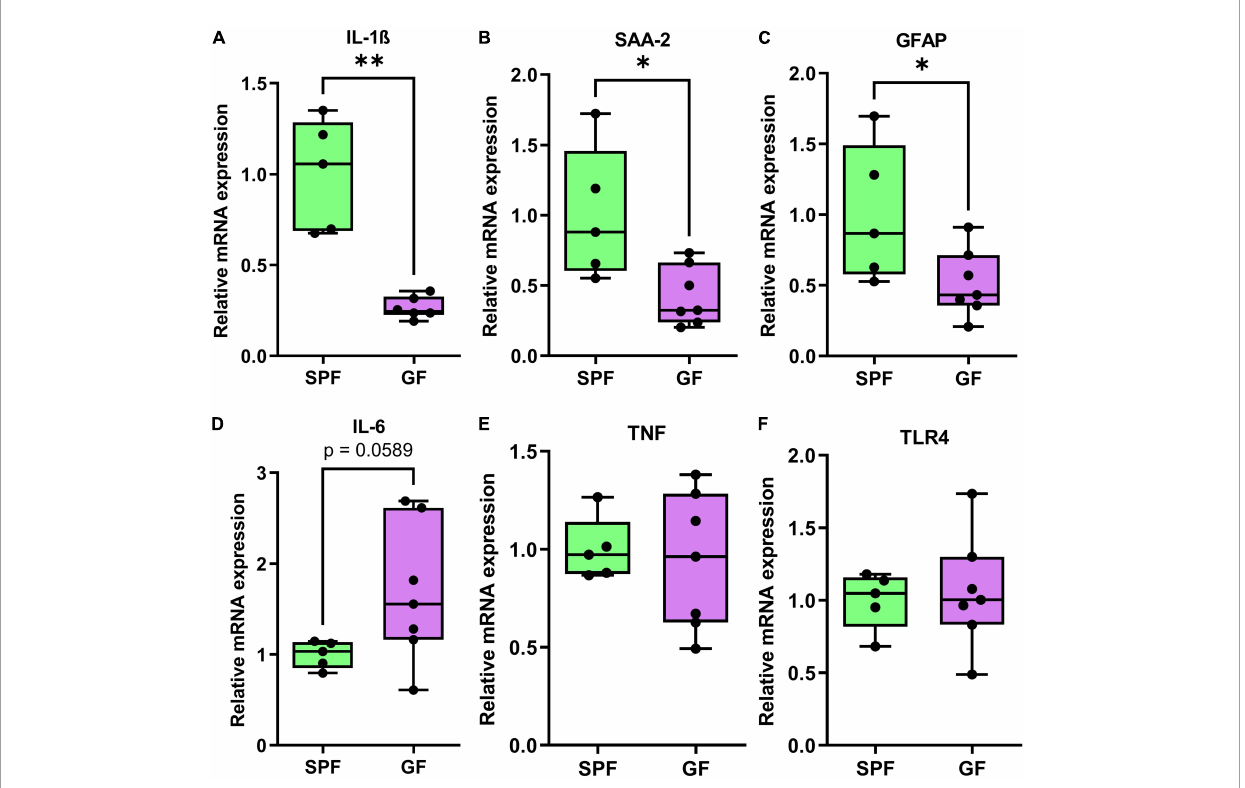
FIGURE7 qPCR genes analysis of liver tissue in GF ( n = 7) and SPF ( n = 5) mice. Boxplots represent the interquartile range (IQR) and whiskers display minimum/maximum values. (A) Interleukin-1ß ( p = 0.0050 ∗∗ ), (B) serum amyloid A ( p = 0.0162 ∗ ), and (C) glial fibrillary acidic protein ( p = 0.0424 ∗ ) were all significantly lower in GF. (D) Interleukin-6 ( p = 0.0589) was trending higher in GF animals relative to SPF animals. (E) TNF ( p = 0.7184) and (F) toll-like receptor-4 ( p = 0.7961) were not significantly different between GF and SPF